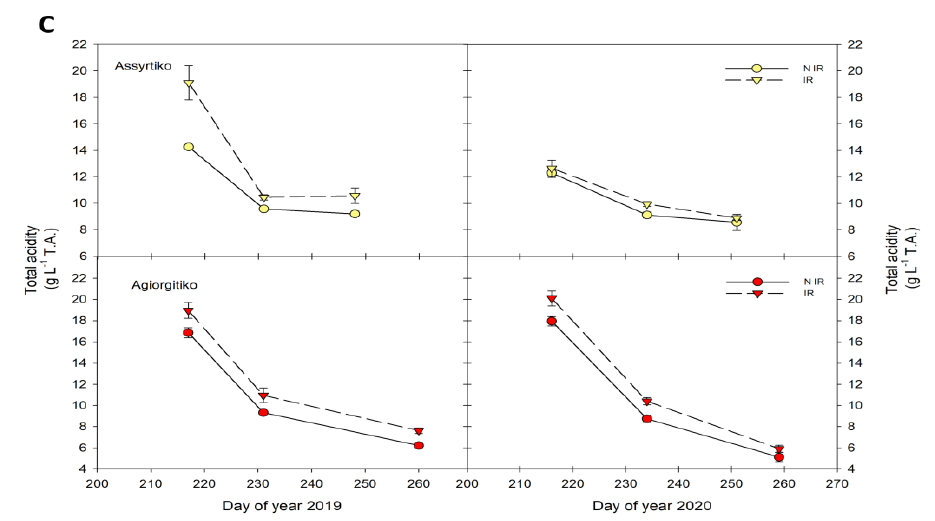
Figure 2. The effect of water deficit on grape berry characters during ripening. ( A ). Berry weight ( B ). Total soluble solids (°Brix). ( C ). Berry titratable acidity. Vertical bars indicate the standard deviation of mean values. IR, irrigated; NIR, non-irrigated.